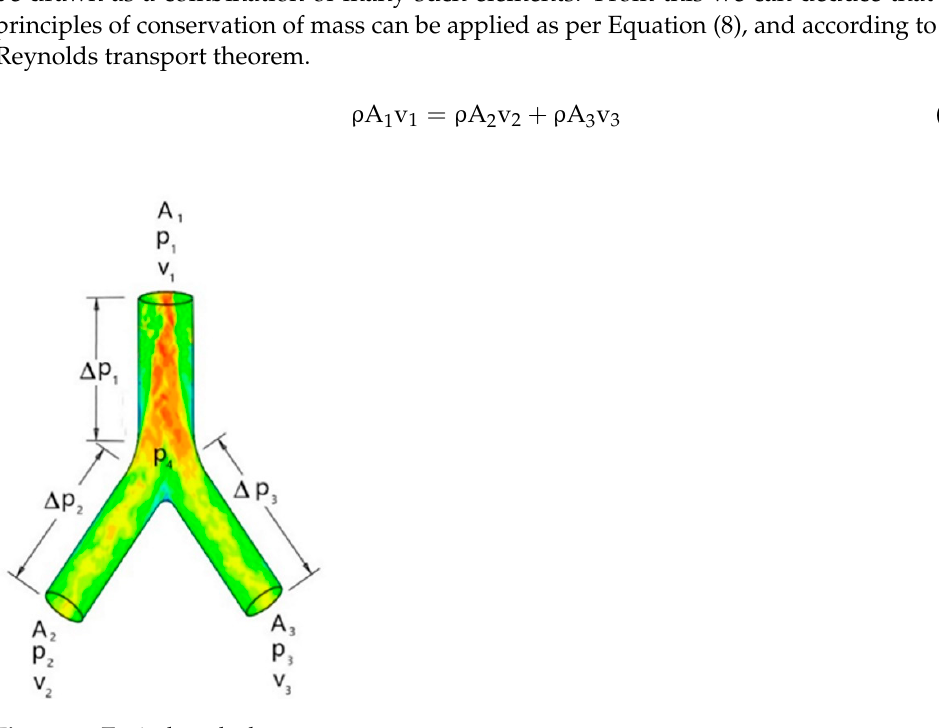
Figure 17. Typical mesh